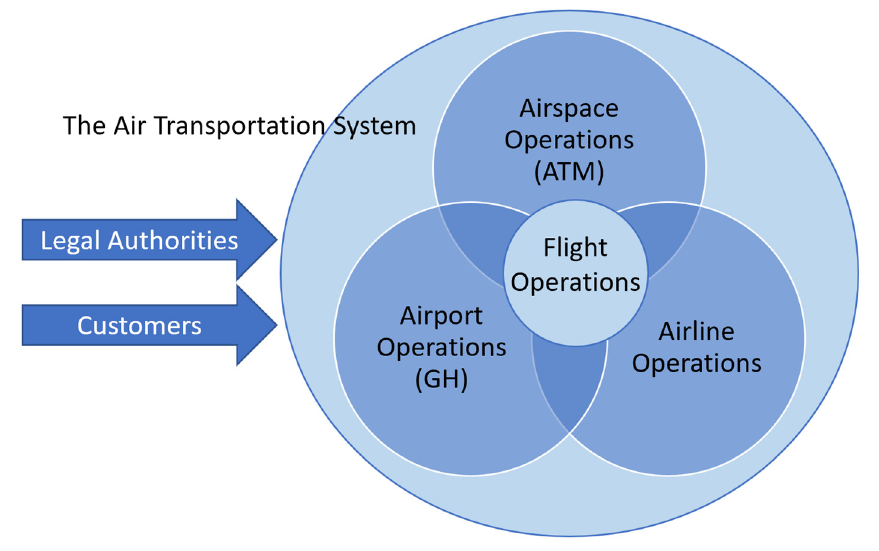
Figure 2. The air transportation system as a system of systems. Derived and adapted from Karish et al., 2019. p. 286 [4].